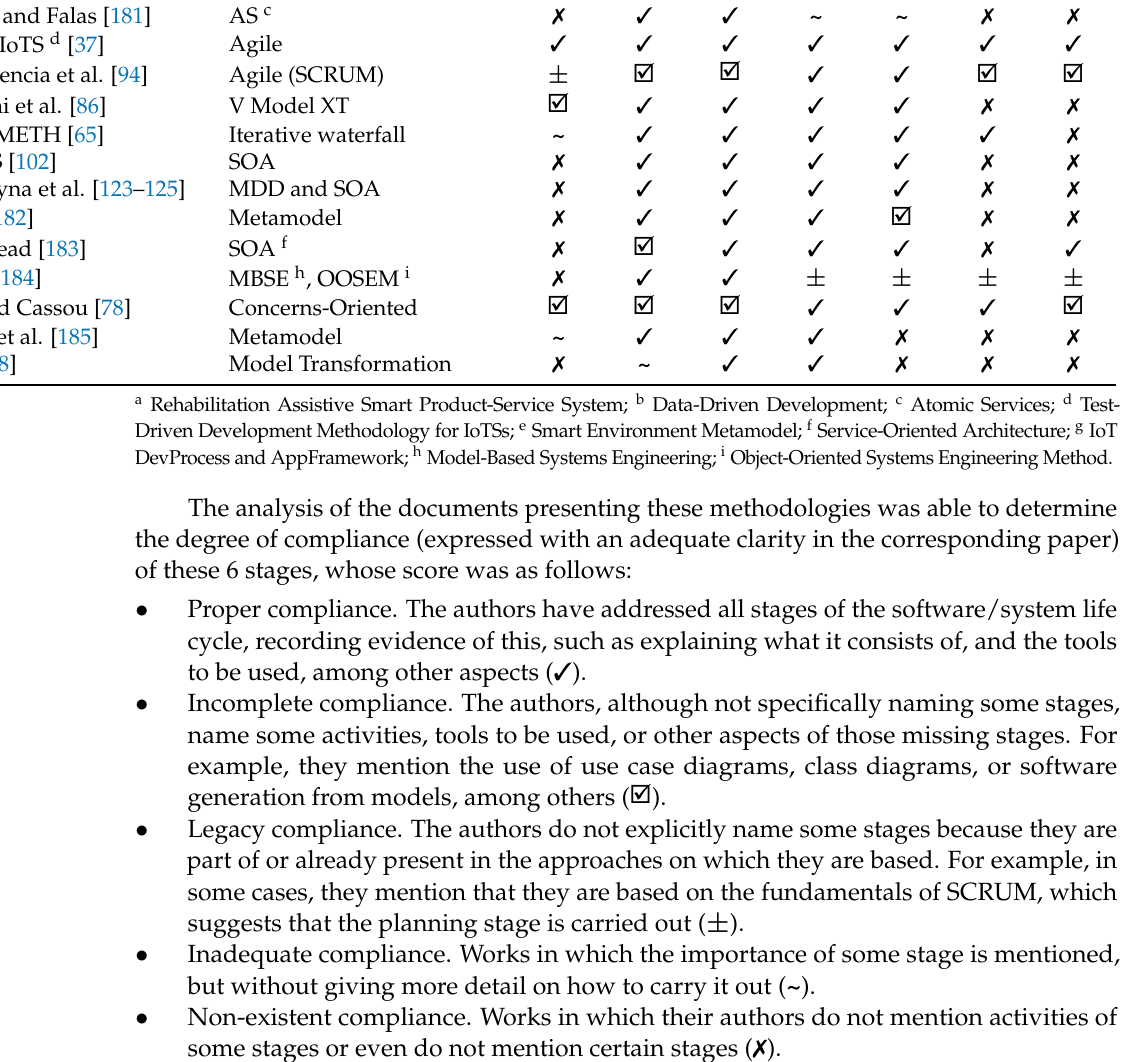
Table 3. Methodologies specifying the stages of the life cycle.